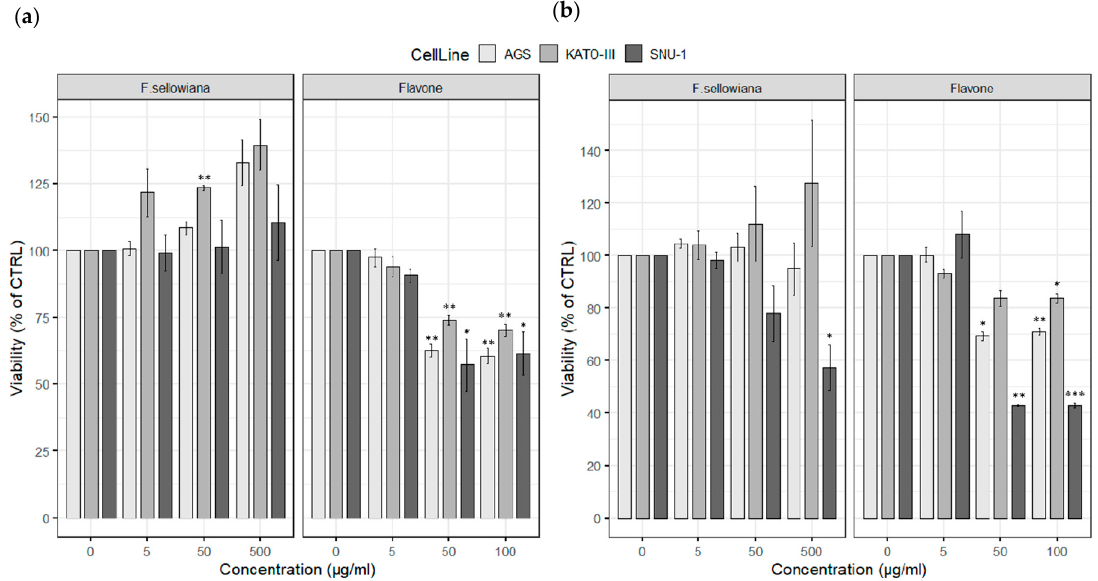
Figure 2. E ff ects of three di ff erent concentrations of F. sellowiana acetonic extract or flavone on cell proliferation. AGS, KATOIII and SNU-1 cells were treated for 24 h ( a ) and for 48 h ( b ). MTS assay was used to determine cell proliferation. Data were expressed as % of the number of viable, metabolically active cells compared to the control. Data were presented as mean and standard error of three individual experiments and analyzed with one sample t -test. * p < 0.05, ** p < 0.001 and *** p < 0.0001.